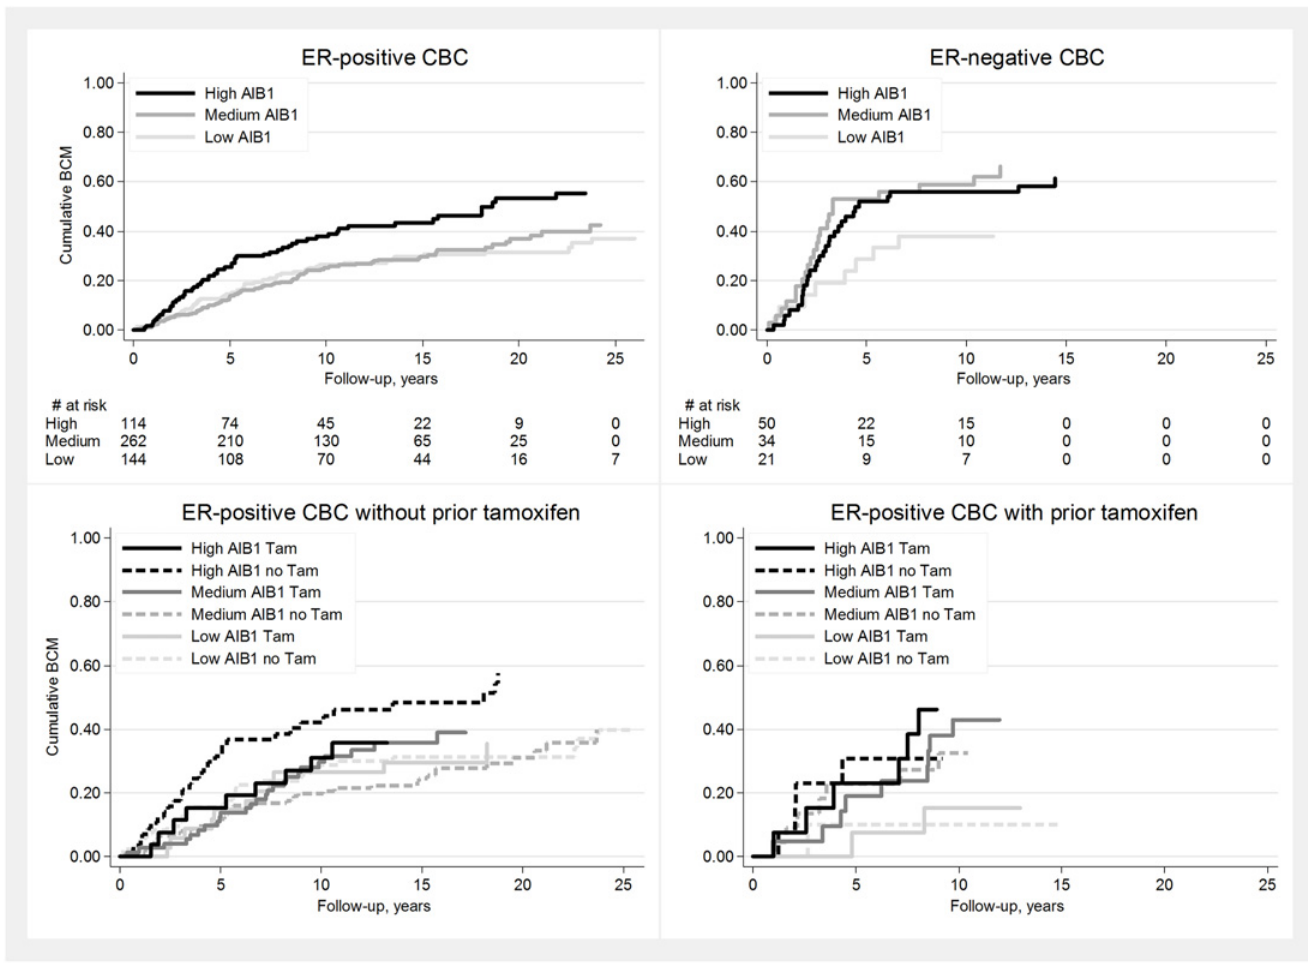
Fig 2. Breast cancer mortality in relation to AIB1-expression in the CBC A. ER-positive CBC. B. ER-negative CBC. C. ER-positive CBC not previously exposed to tamoxifen. D. ER-positive CBC developed despite prior tamoxifen. A high AIB1-expression was associated with a worse BCM in ER-positive CBC (A), but not in ER-negative CBC (B). However, in ER-positive CBC not previously exposed to tamoxifen, a worse BCM with a high-AIB1 was only seen if tamoxifen was not given for the CBC (C). If treated with tamoxifen, on the other hand, AIB1-high CBC had an equally good prognosis as tumors with lower AIB1-expression. This is consistent with previous studies, and indicates a response to tamoxifen in AIB1-high tumors. Conversely, no difference in prognosis was seen in relation to tamoxifen treatment in ER-positive AIB1-high CBC developed despite prior tamoxifen (D). This could reflect an unresponsiveness and possible resistance to tamoxifen in these tumors. All plots were curtailed when < 5 individuals remained at